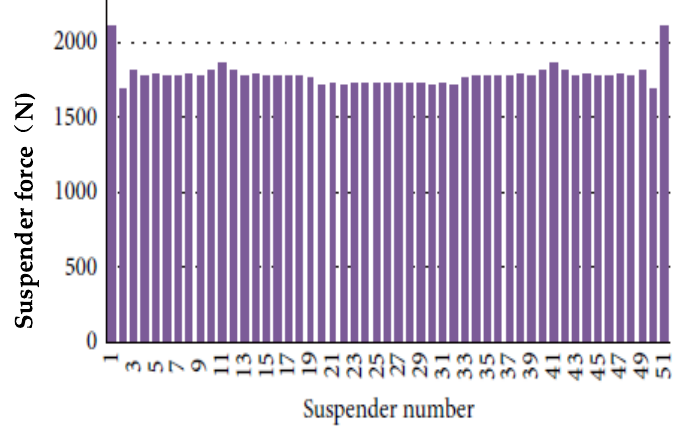
Figure 12. The distribution of the suspender force.